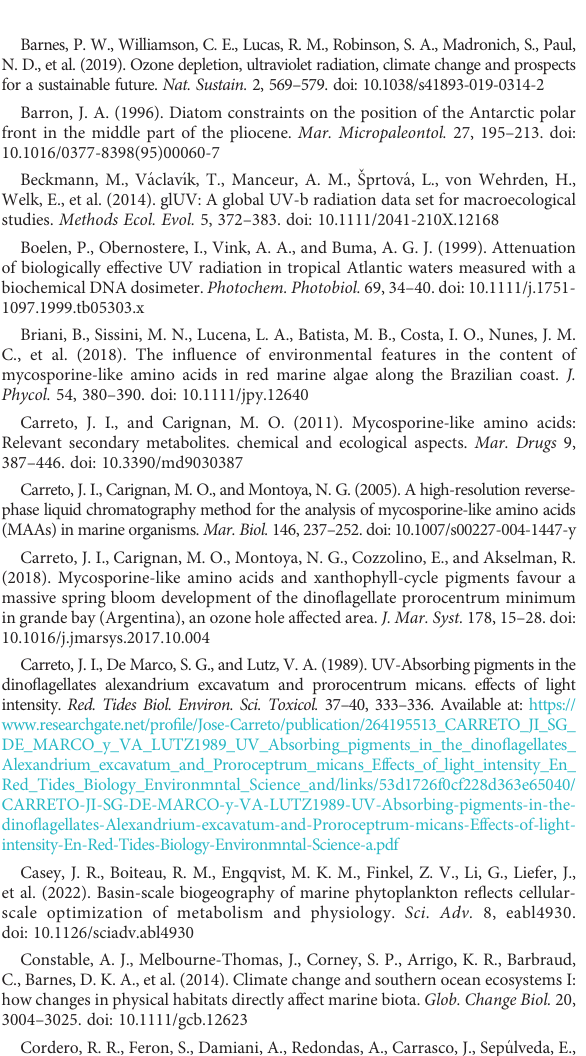
SUPPLEMENTARY FIGURE 3 Scatter plots of modeled UVR dosages for March 2018 versus MAA:chl-a. (A) UVR dosage at 305 nm versus MAA:chl-a. (B) UVR dosage at 325 nm versus MAA:chl-a. SUPPLEMENTARY FIGURE 4 Pearson correlation coef fi cients between abiotic